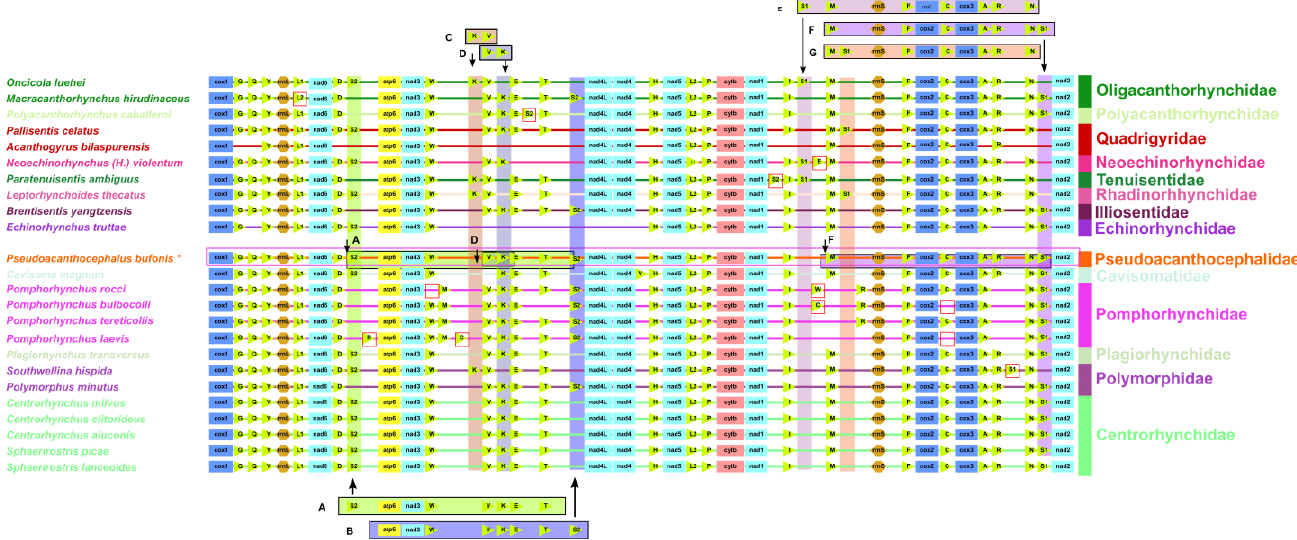
Figure 6. Comparison of the linearized mitochondrial genome arrangement for 24 acanthocephalans species. All genes are transcribed in the same direction, from left to right. The tRNAs are labelled by a single-letter code for the corresponding amino acid. A–B: the position of trnS2 ; C–D: the position of trnK ; E–G: the position of trnS1 . Translocations of individual tRNAs are marked with red boxes. The shadowed regions highlighted bin pink represent Pomphorhynchidae ( Pseudoacanthocephalus bufonis indicated by asterisk).